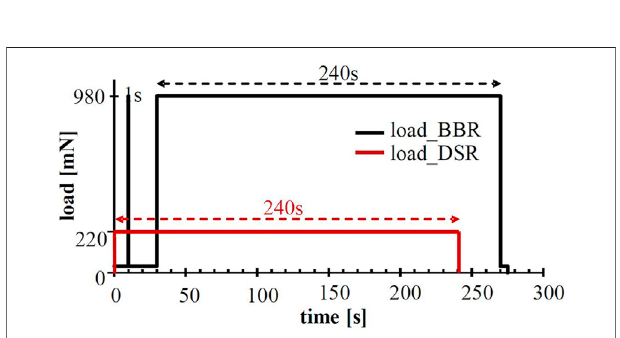
FIGURE 4 | Loading scheme of DSR test, in comparison to BBR